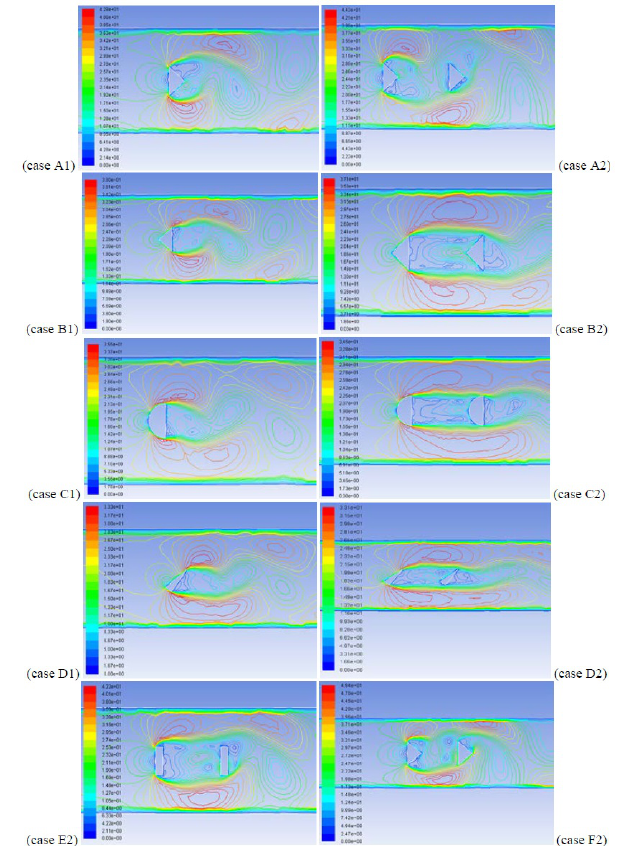
Figure 4: Instantaneous velocity isolines (at time 8 ms) near the bluff